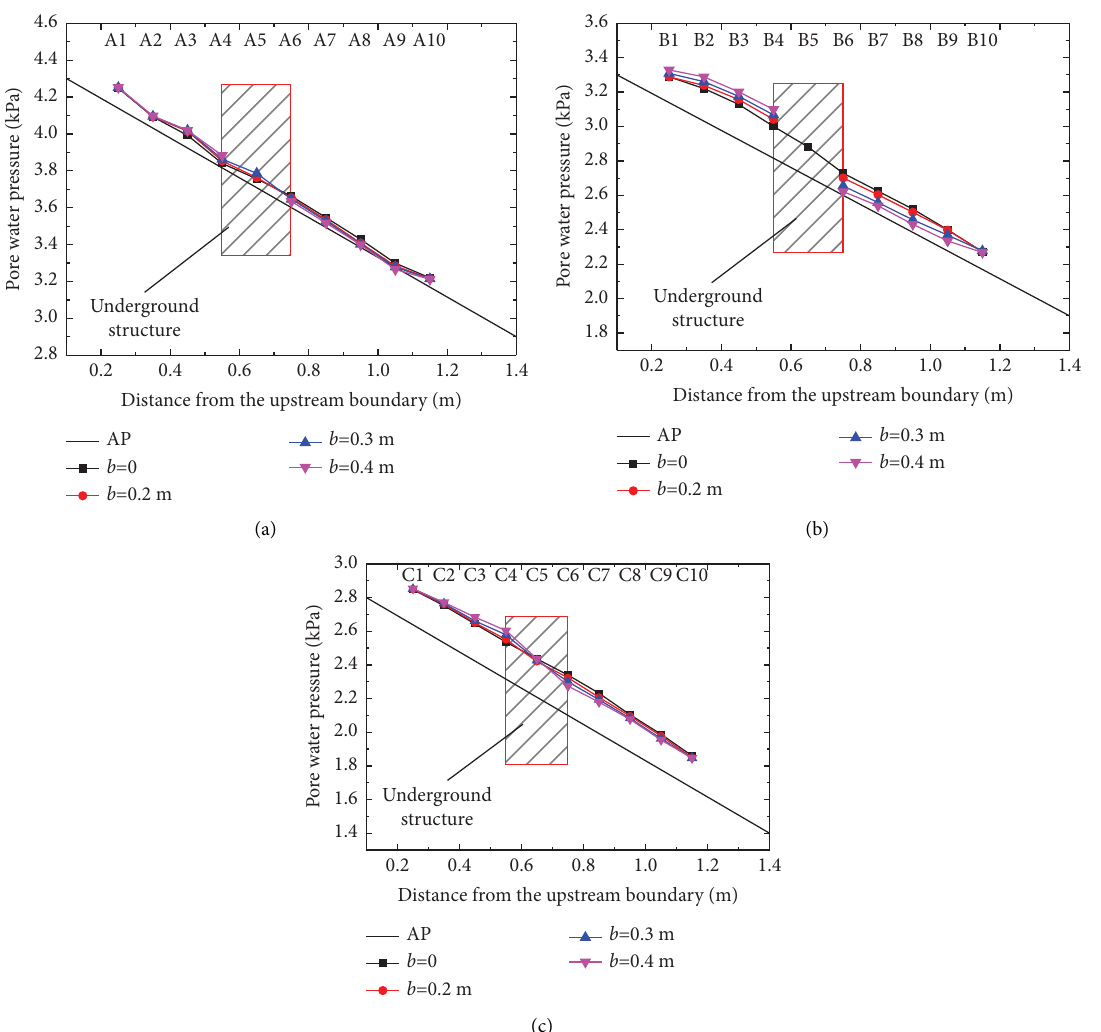
Figure 3: Longitudinal distribution of pore water pressure for diferent structure widths. (a) Row A. (b) Row B. (c) Row C.